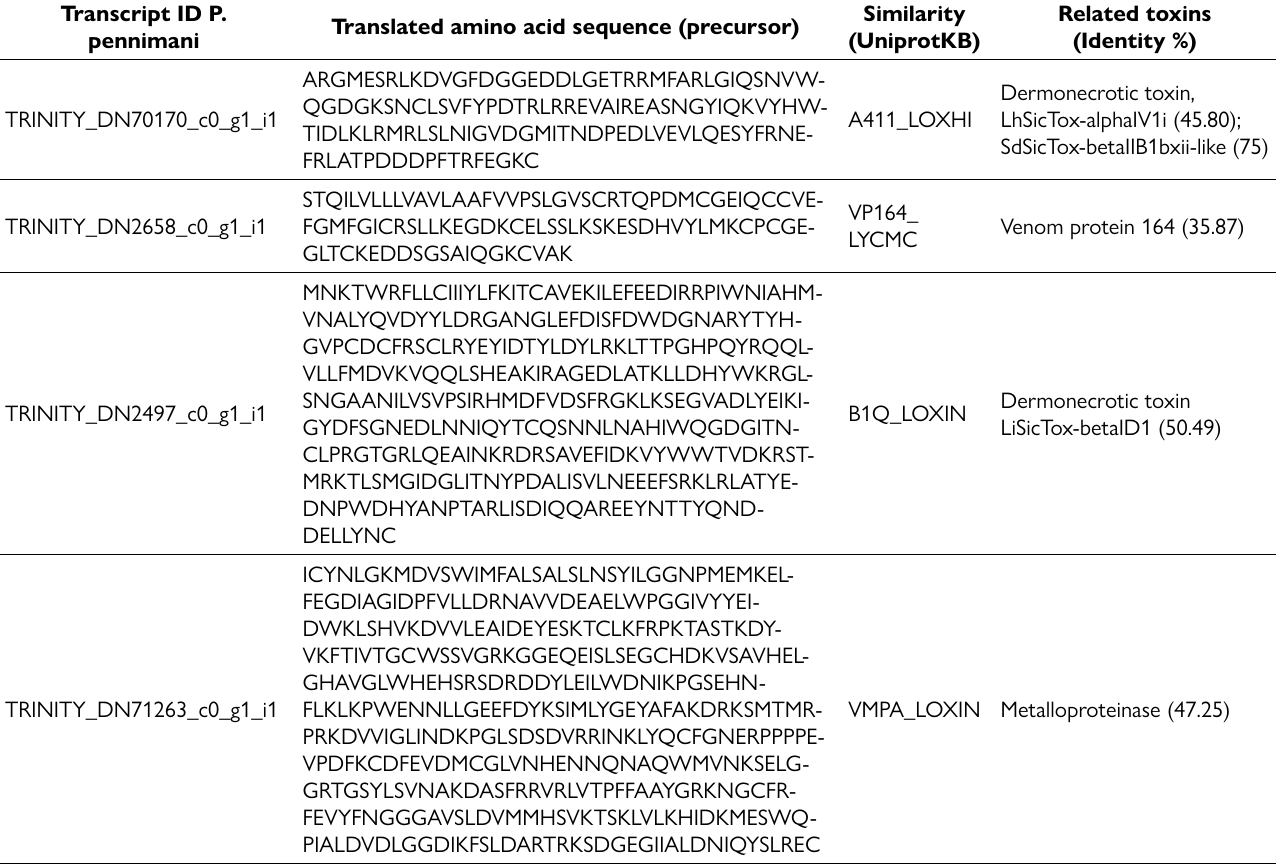
Table 2. Amino acid sequences translated from Phonotimpus pennimani transcripts that showed similarity to toxins or other arachnid venom components. Transcript ID